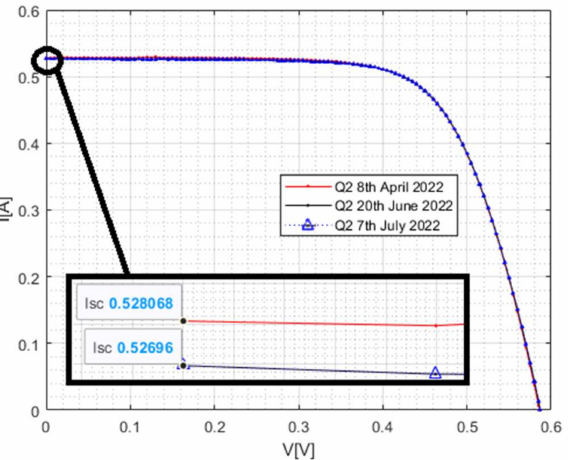
Figure 7. I-V characteristic for encapsulated and PA Si-QDs coated Q2 sample carried 74- and 91-days post encapsulation